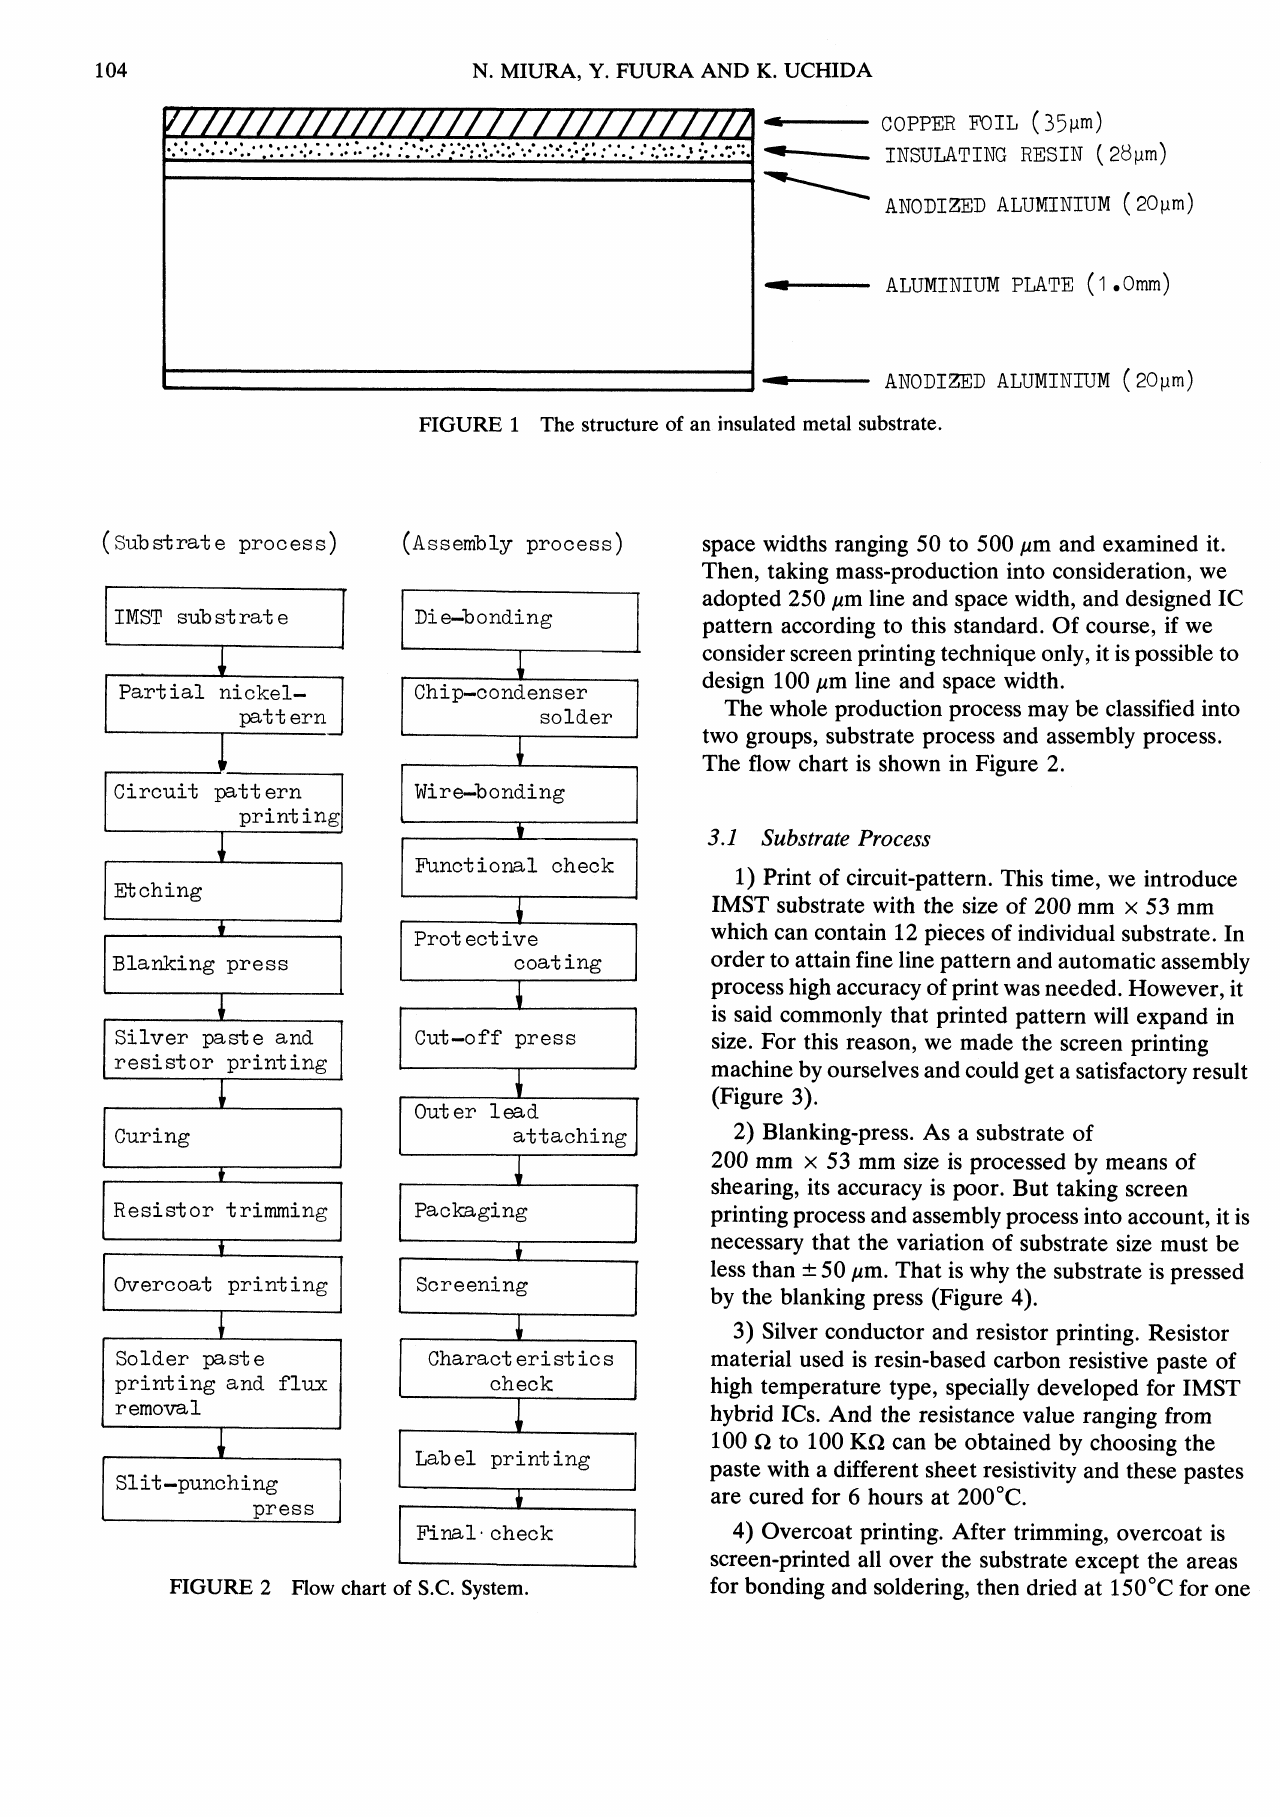
FIGURE 1 The structure of an insulated metal substrate.